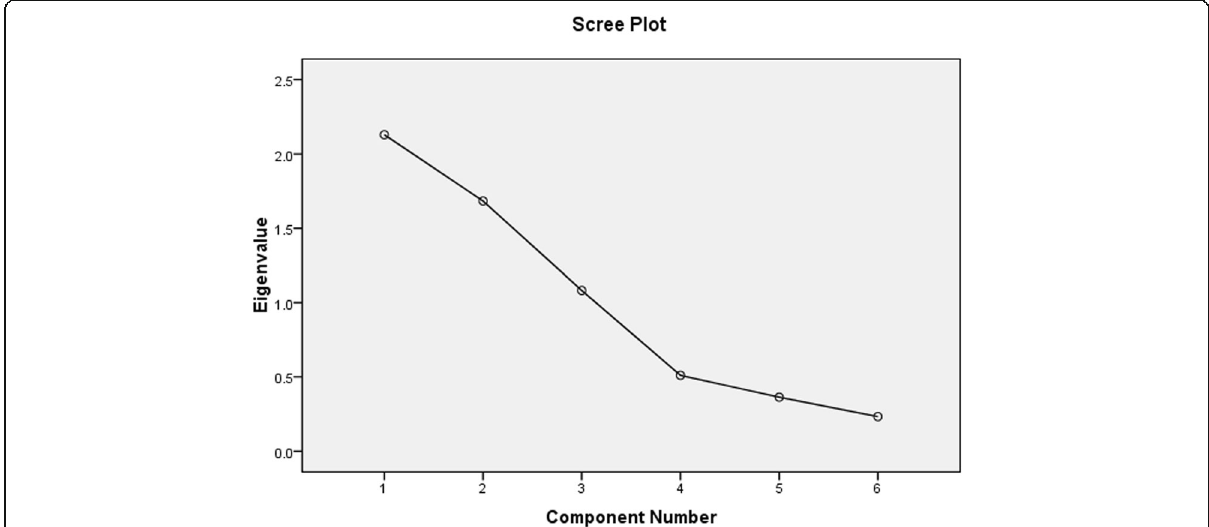
Fig. 8 Scree plot of eigenvalue of principal components for agriculture land